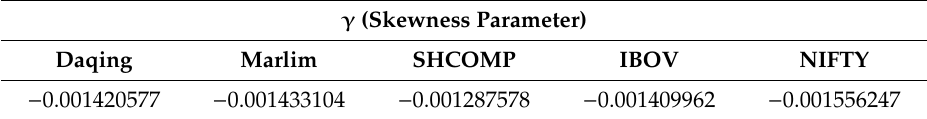
Table A12. MNIG Skewness parameter γ for Vector 3: Daqing, Marlim, SHCOMP, IBOV, NIFTY. γ (Skewness Parameter)